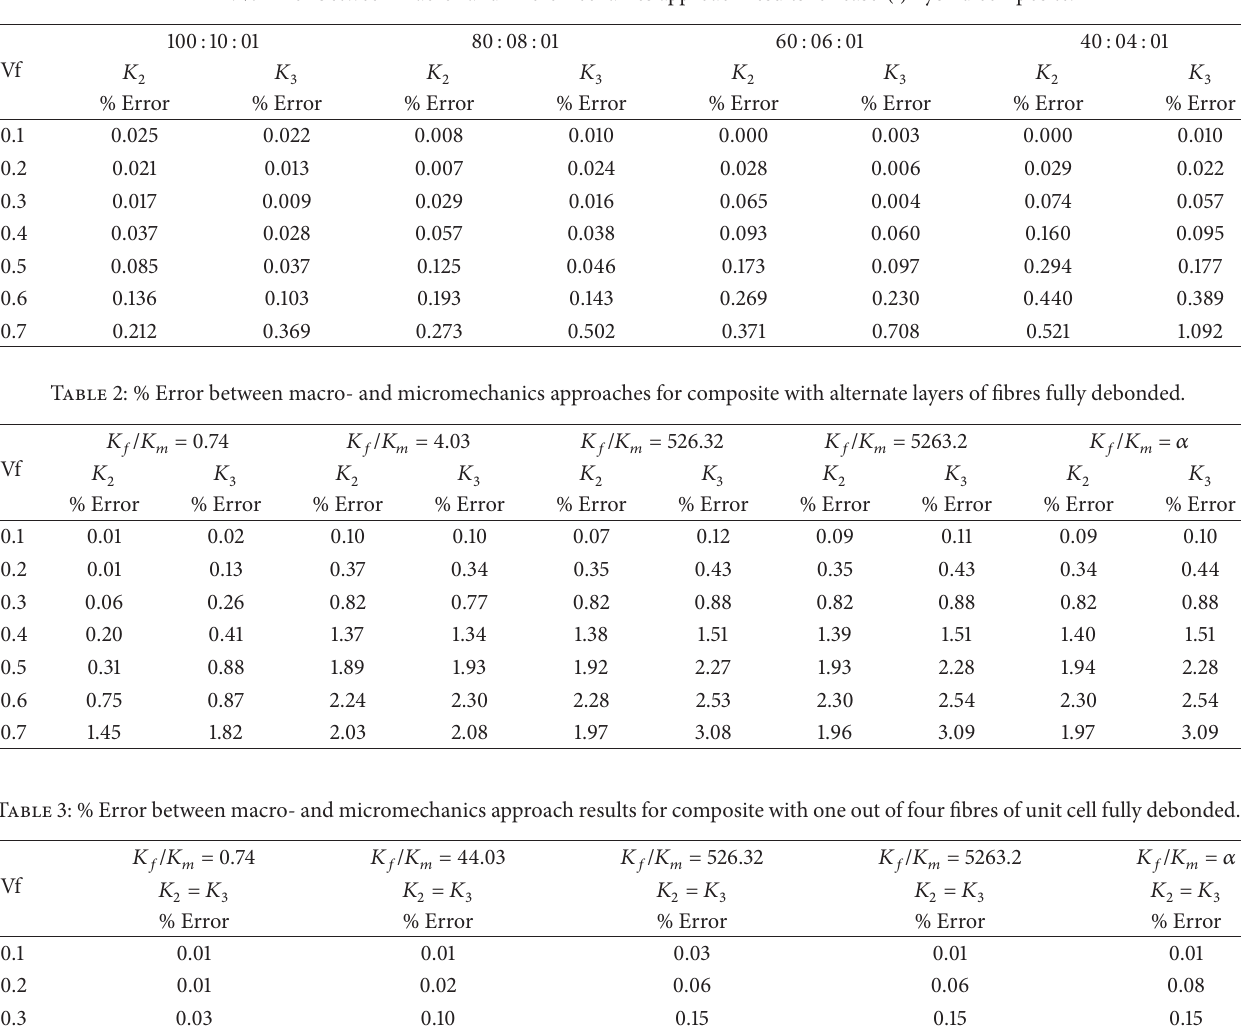
Table 1: % Error between macro- and micromechanics approach results for case-(i) hybrid composite.